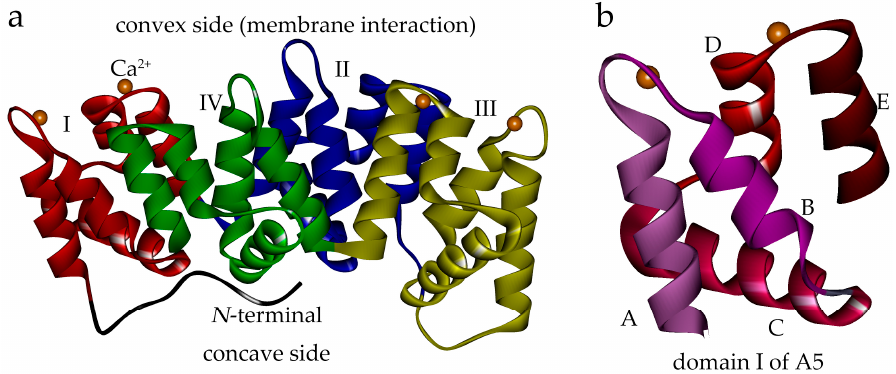
Figure 1. Human annexin A5 (anxA5) structure (PDB: 1ANX). ( a ) The anxA5 is structurally comprised of an N-terminal (black) and a C-terminal core composed of four domains. The convex side harbors calcium binding sites and is responsible for binding the membrane. The domains and Ca 2+ are shown in different colors: domain I, red; domain II, blue; domain III, yellow; domain IV, green; Ca 2+ , orange balls. ( b ) Domain I of anxA5 as an example of the repeated domains. Each repeated domain is composed of five α -helices: A, B, C, D and E.